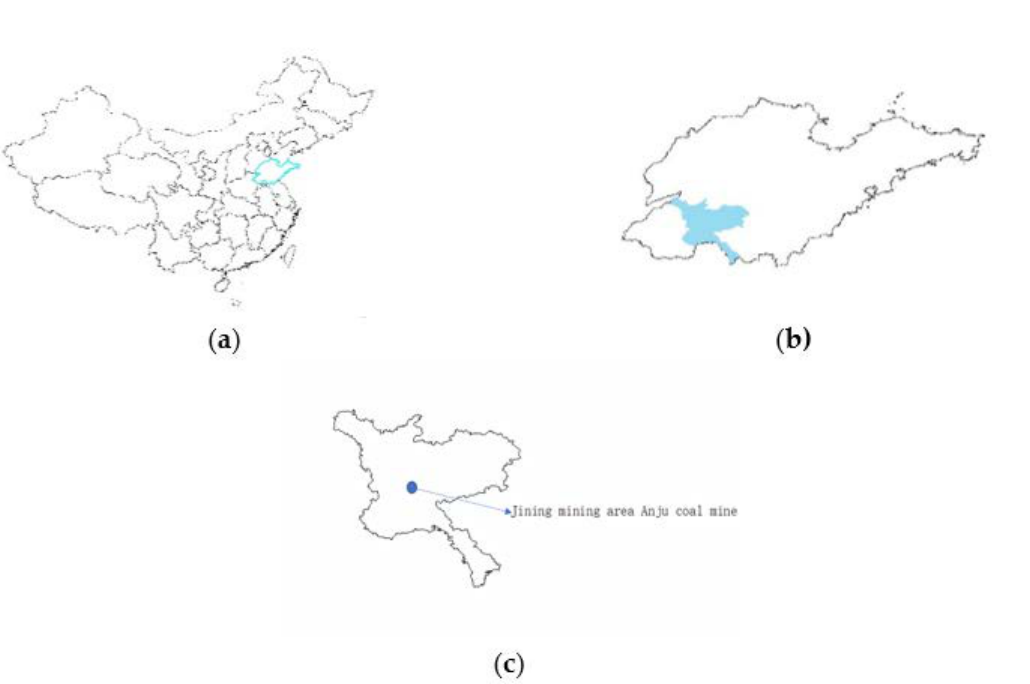
Figure 1. Mine Location Map: ( a ) Map of China. ( b ) Map of Shandong. ( c ) Diagram of Anju Coal Mine in Jining Mining